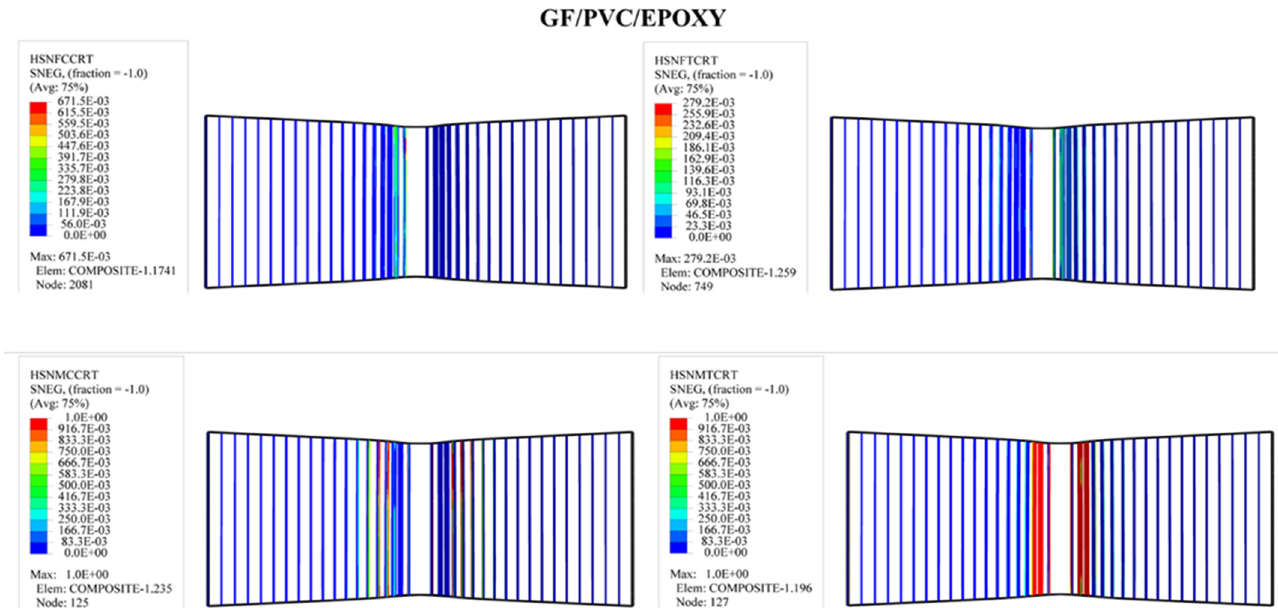
Figure 12. Numerical Hashin’s damage initiation of the upper skin of GF/PVC/Epoxy sandwich composites.